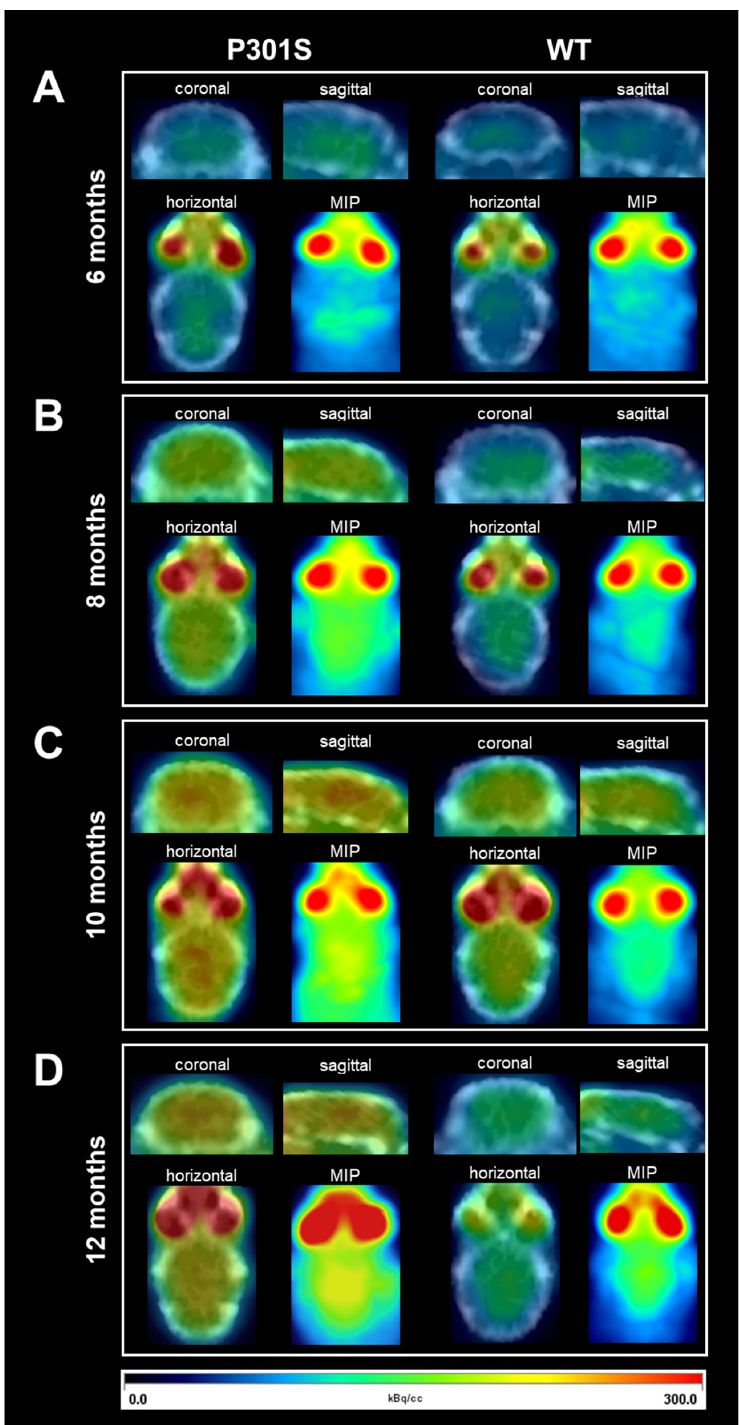
Figure 1. Longitudinal 18 F-THK5351 tau PET imaging of P301S and WT mice. Illustrative images from positron emission tomography and computerized tomography (PET/CT) imaging in coronal, sagittal, and horizontal views, and maximum intensity projection (MIP) of tau tracer 18 F-THK5351 uptake in P301S (left) and WT mice (right). Longitudinal analysis was performed at 6 ( A ), 8 ( B ), 10 ( C ), and 12 ( D ) months of age. Images reveal increased PET/CT and MIP signal over time within the same individual, specifically in P301S mice. Color gradient indicates PET signal intensity from black-dark blue (0) to red (300). Color values are indicated in kBq/cc.